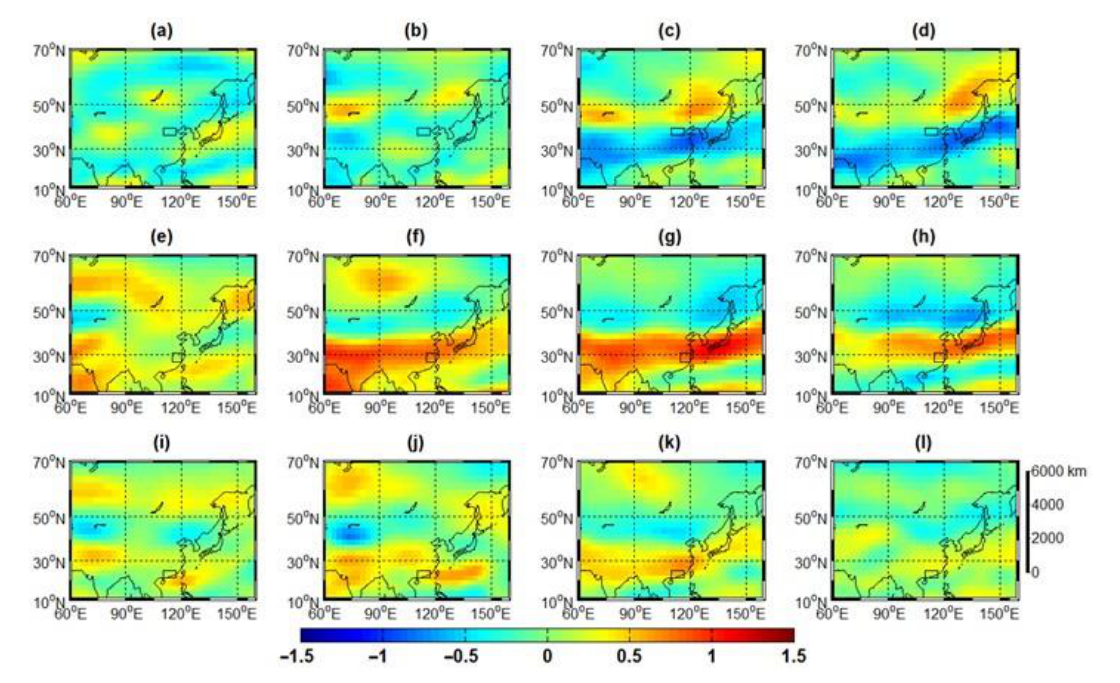
Figure 7. As in Figure 6, but for 200-hPa zonal winds. ( a – d ) North China (NC), ( e – h ) Yangtze River Valley (YRV), and ( i – l ) South China (SC).